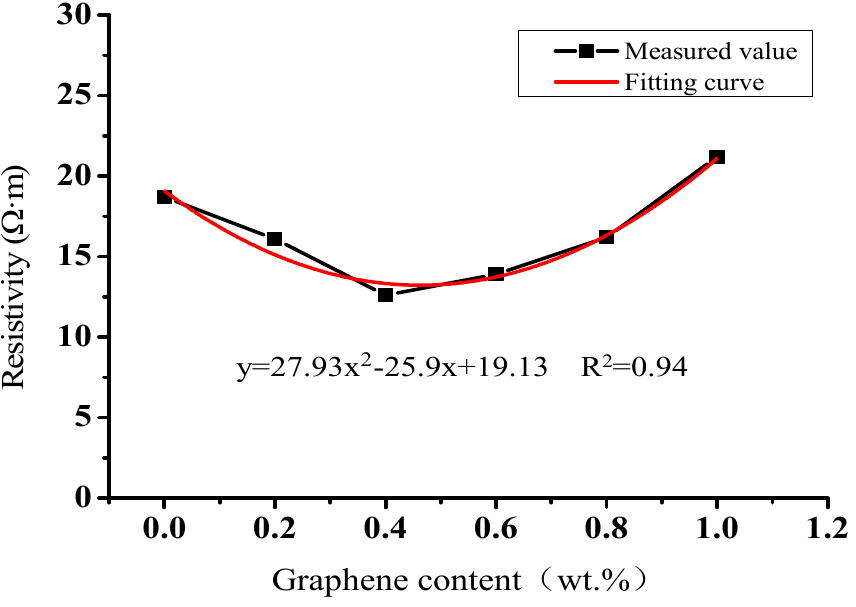
Figure 3. Relationship curve between graphene content and 28 d age resistivity of graphene composite conductive concrete.